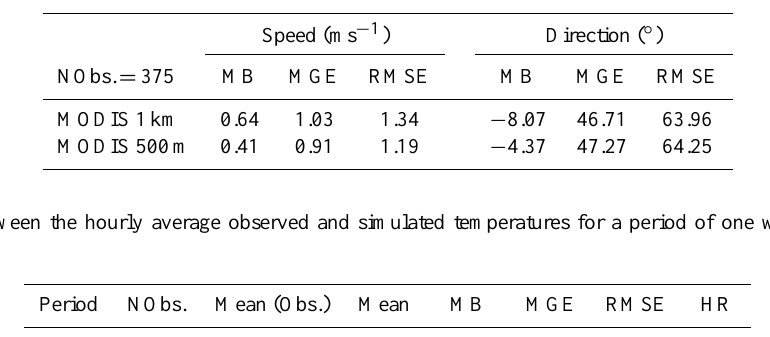
Table 3. Same as Table 1 but for wind speed (ms − 1 ) and direction ( ◦ ).